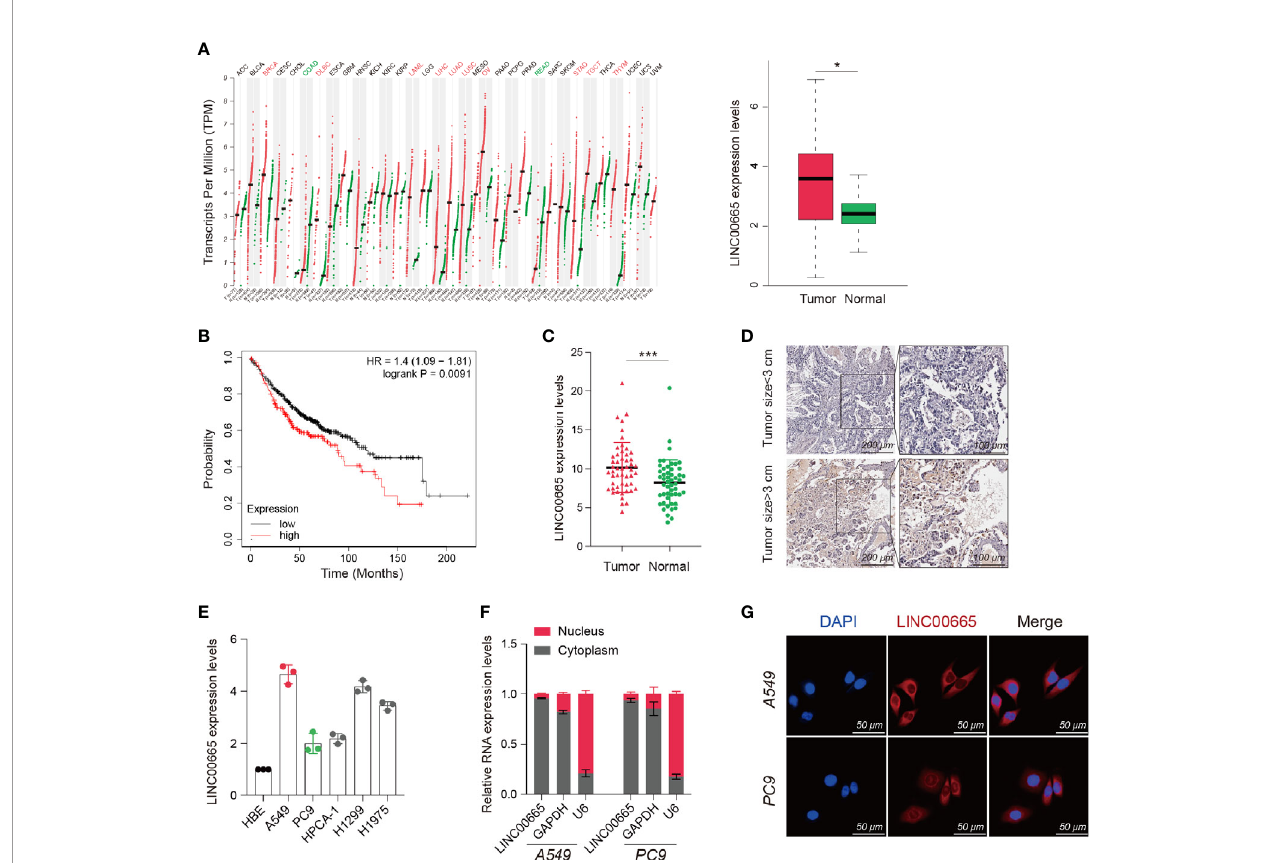
FIGURE 1 | Identi fi cation, characterization, and clinical signi fi cance of LINC00665 in LUAD. (A) LINC00665 expression in multiple TUMOR and NORMAL tissues (Data from TCGA). (B) Kaplan-Meier survival analysis of LUAD patients with higher or lower levels of LINC00665. (C) LINC00665 expression in 52 pairs of LUAD and adjacent normal tissues measured using qRT-PCR. (D) LINC00665 FISH of 52 pairs of LUAD and adjacent normal tissues, tumor size ≥ 3cm or <3cm. (E) LINC00665 expression in HBE and multiple LUAD cell lines measured using qRT-PCR. (F) LINC00665 abundant in the cytoplasm of A549 and PC9 cells. GAPDH and U6 were used as positive controls in the cytoplasm and nucleus, respectively. (G) FISH assays showing the location of LINC00665 in A549 and PC9 cells, scale bars, 50 m m. *p < 0.05; ***p <